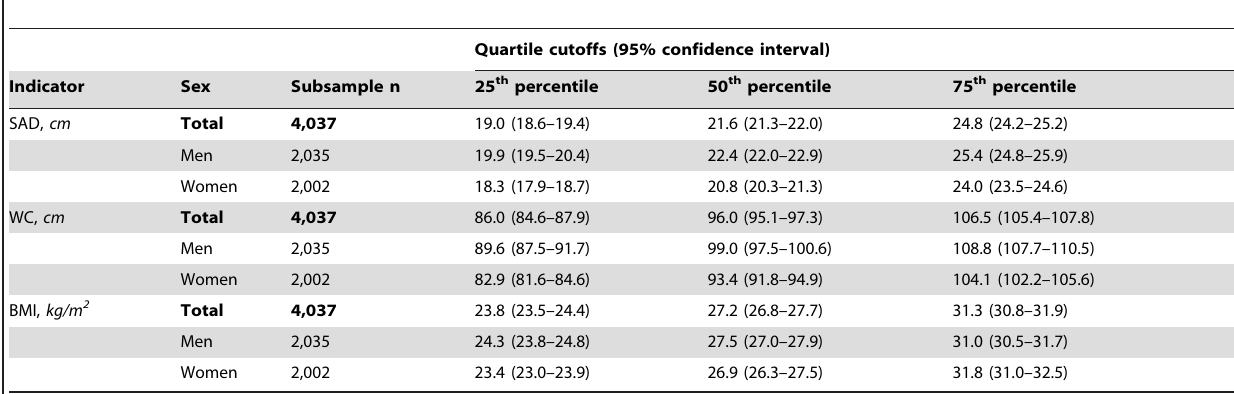
Table 2. Subpopulation quartile cutoffs of adiposity indicators in US adults ages $ 20 years without diagnosed diabetes, estimated from NHANES 2011–2012.